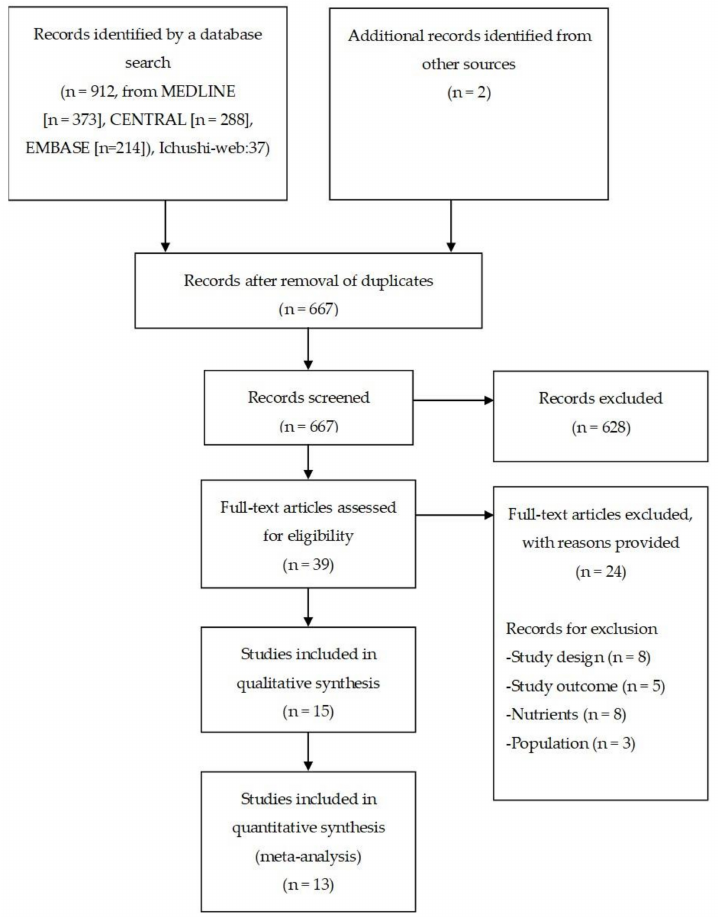
Figure 1. Flowchart of the study selection